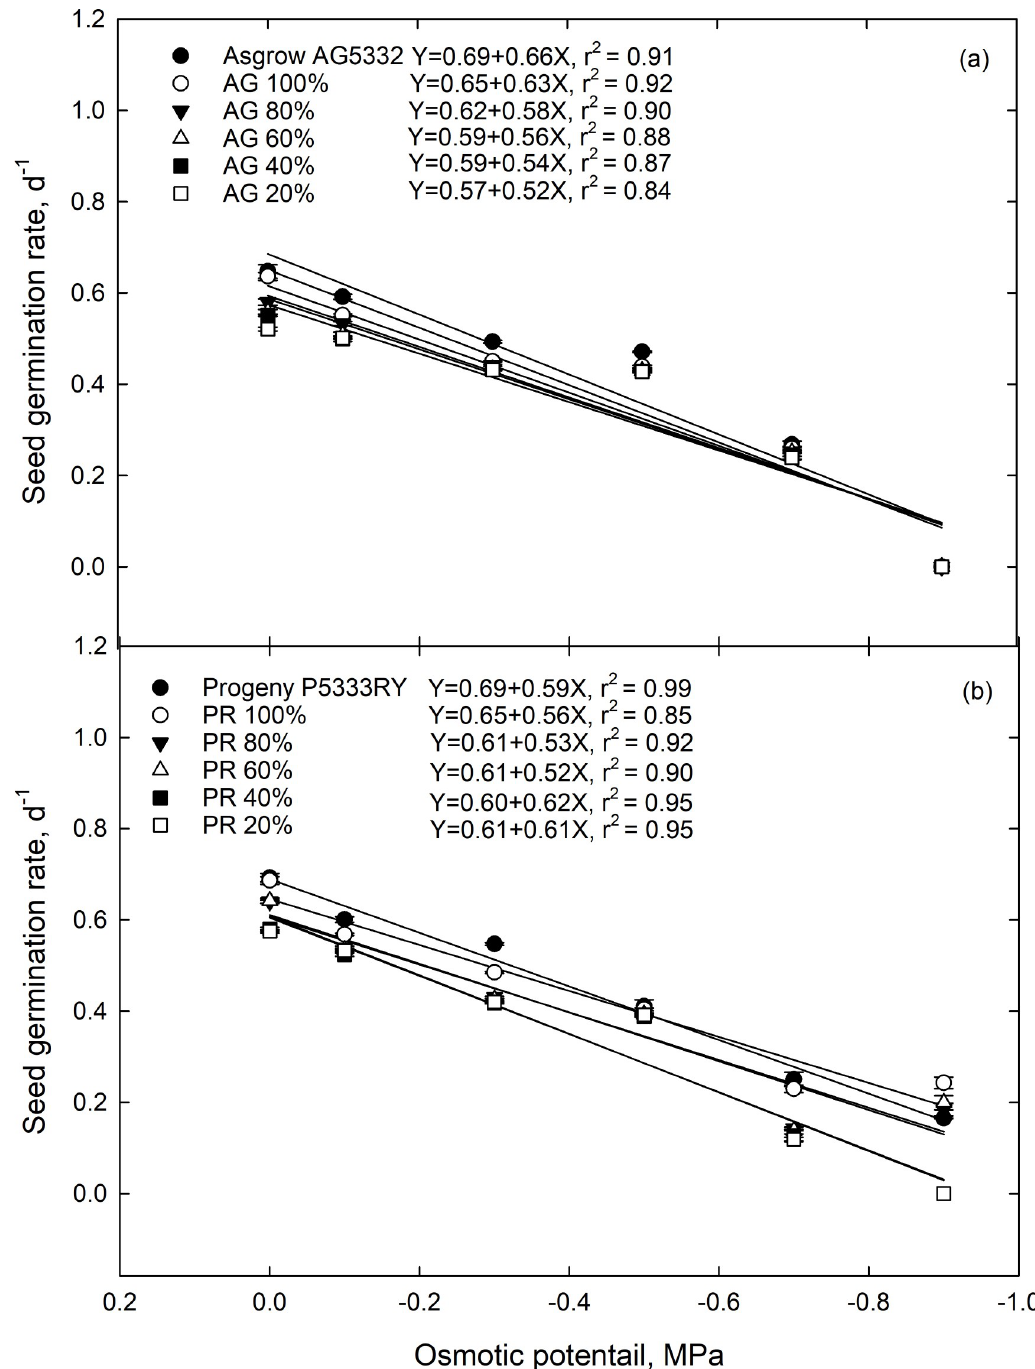
Fig 4. The germination rate of soybean seed from the F1 generation as a function of osmotic potential. F1 seed was collected from the soybean cultivar (a) Asgrow AG5332 and (b) Progeny P5333RY after exposure to drought stress including replacement of 100, 80, 60, 40, and 20% of the evapotranspiration demand. Symbols represent the mean of four replications, while bars represent the standard error. Lines are the best fit of a quadratic function.